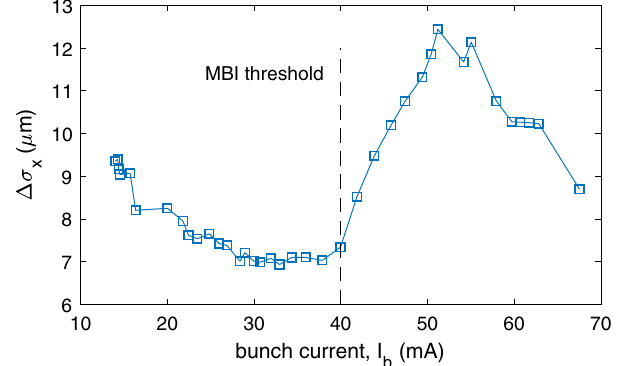
FIG. 11. Difference between the horizontal beam size measured in single bunch mode and multi-bunch mode for the same total current. The multi-bunch beam size is subtracted to remove effects of camera exposure time and gain. With vertical chro- ¼ 5 , up to 70 mA in a single bunch has been stored maticity at C y in